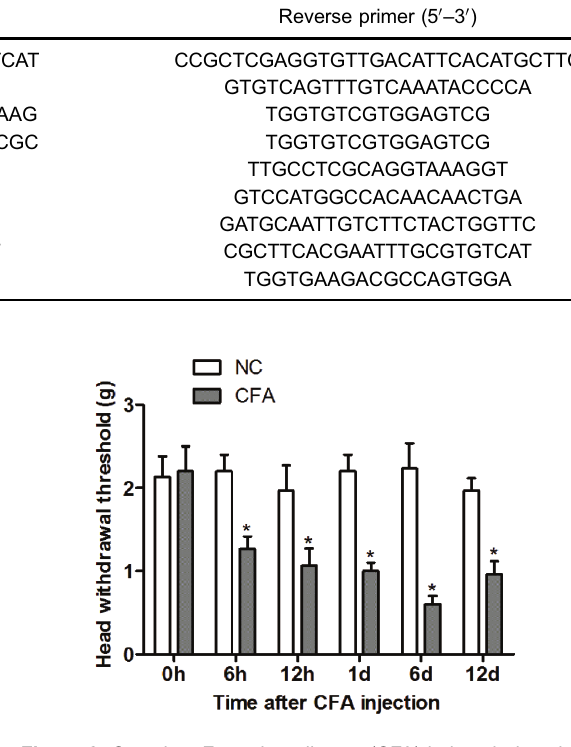
Figure 2. Complete Freund ’ s adjuvant (CFA) induced trigeminal neuropathic pain in mice. The head withdrawal thresholds were measured in ipsilateral orofacial regions at different time-points (n=6). Data are reported as means ± SD. *P o 0.05 vs control group (NC) (ANOVA followed by a post hoc Tukey ’ s